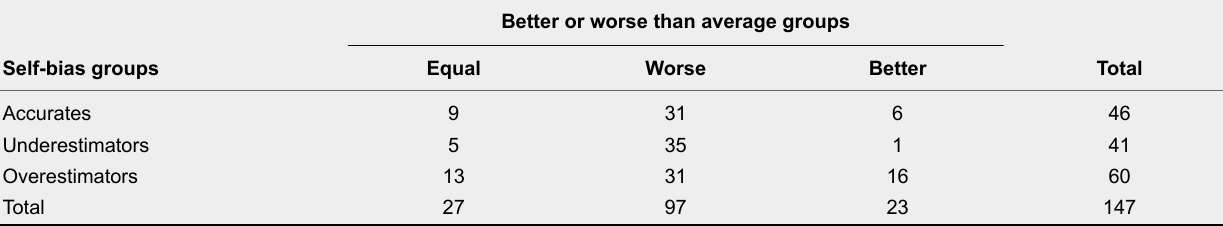
Better or worse than average groups TotalEqual Worse Better